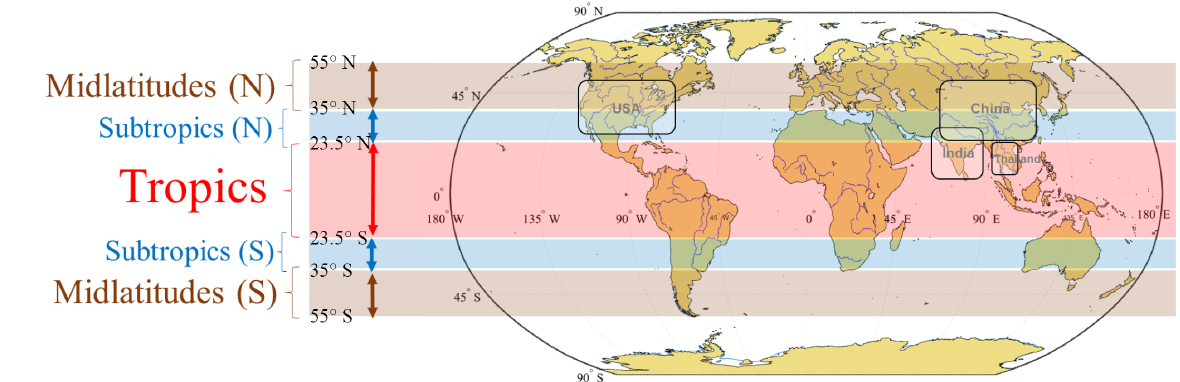
Figure 1. Spatial segmentation to assign the global flood events (1985 to 2015) into different latitudinal belts: midlatitudes (N): 35–55 ◦ N; subtropics (N): 23.5–35 ◦ N; tropics: 23.5 ◦ S–23.5 ◦ N; subtropics (S): 23.5–35 ◦ S; and midlatitudes (S): 35–55 ◦ S; (N) and (S) indicate North- ern Hemisphere and Southern Hemisphere, respectively; the four rounded rectangles shows the United States of America (USA), China, India, and